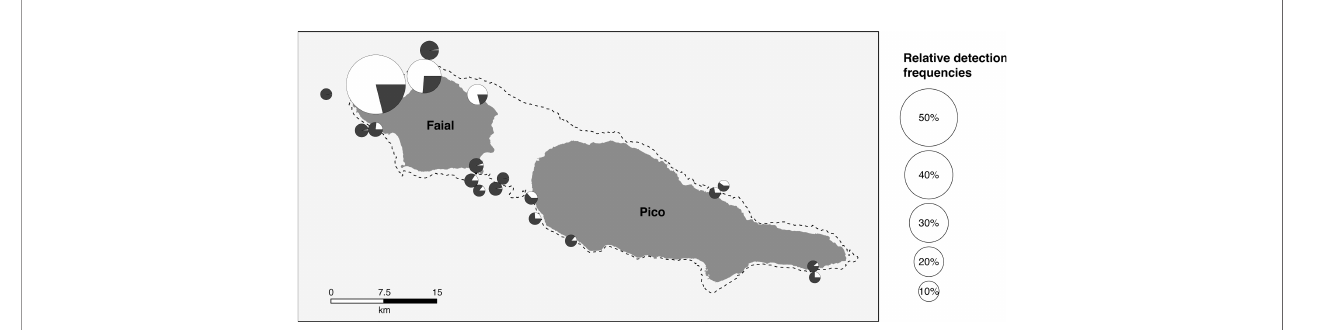
FIGURE 7 | Proportion of detection frequencies per diel phase (white for daytime, black for nighttime) and receiver for nine acoustically tagged smooth hammerhead sharks ( Sphyrna zygaena ). Node size is proportional to the average of relative detection frequencies; the dashed line marks the edge of the island